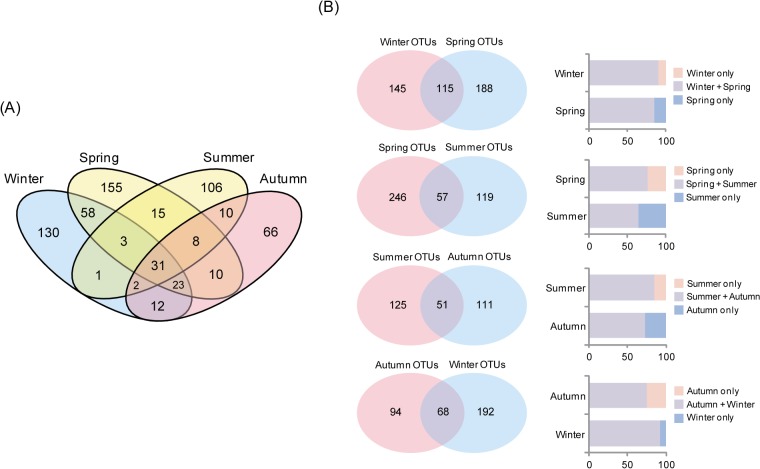
The distribution of OTUs among the seasonal bacterial communities in Gosung Bay.Venn diagrams demonstrating 97% OTU cluster overlap within all seasonal samples (A) or between two different seasons (B). Numbers correspond to unique OTU clusters within a subset. To highlight shared OTUs, singleton clusters were removed before analysis.